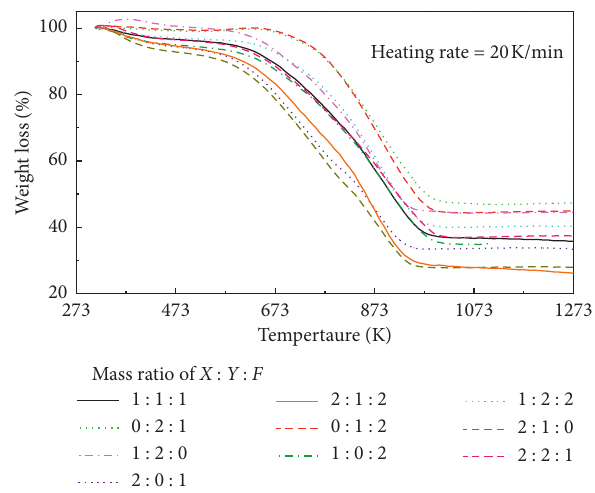
Figure 2: TG curves of mixing coals with different mass